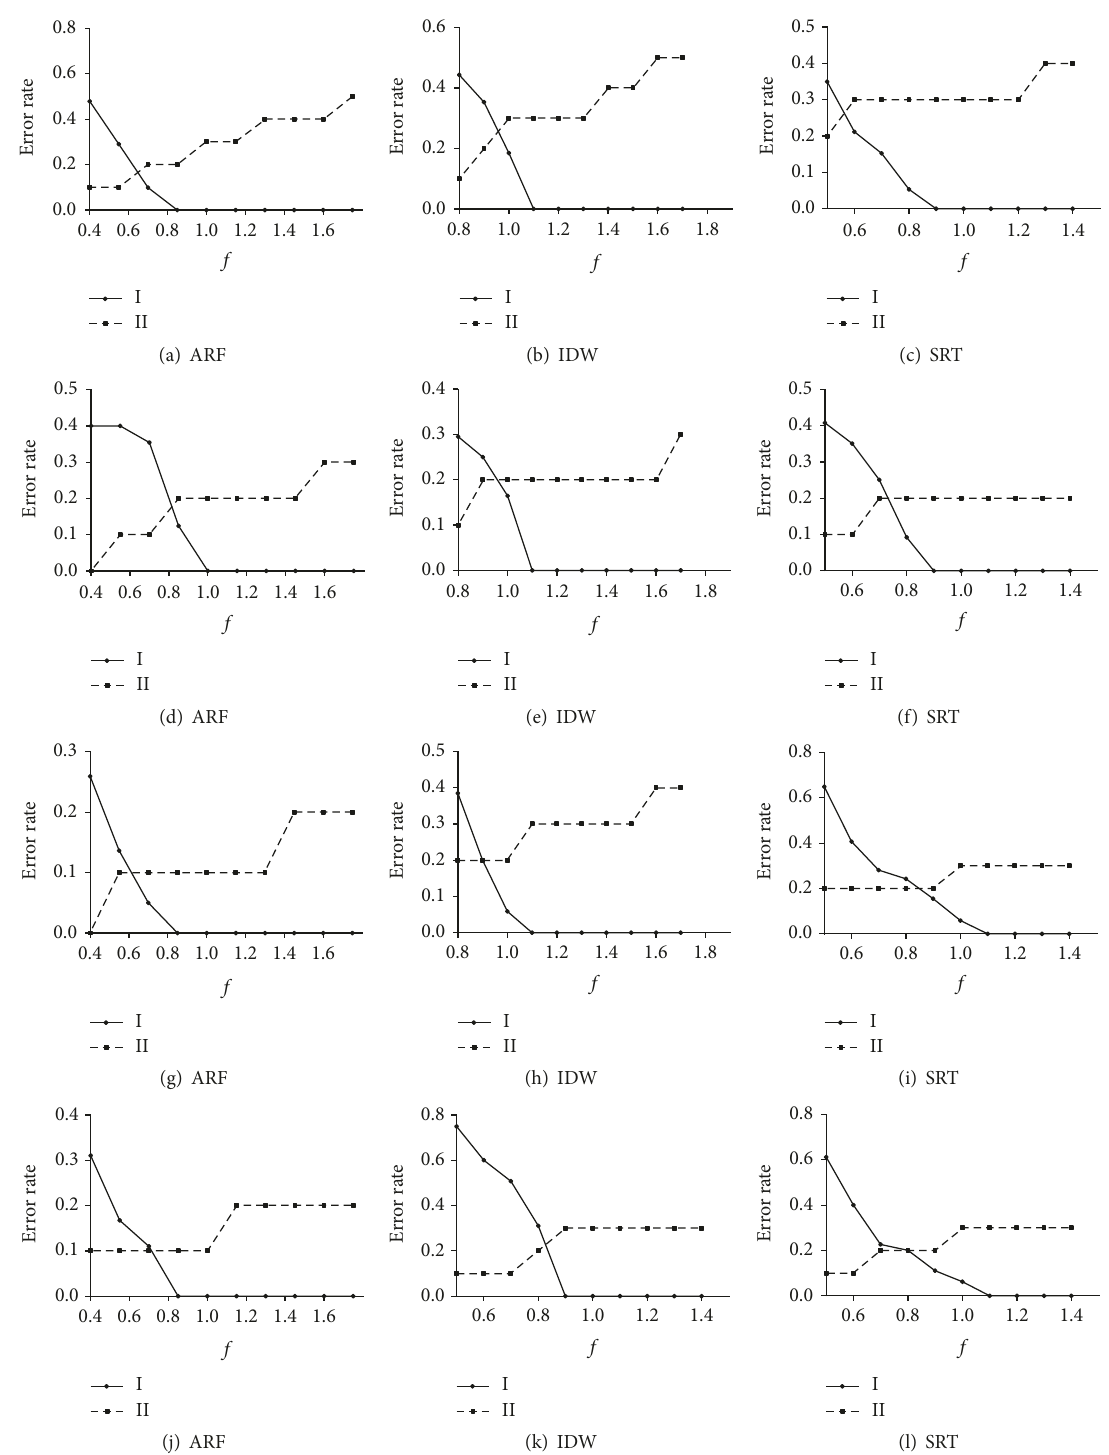
Figure 9: Comparisons of two types of errors for CD at 02:00 (a)–(c), 08:00 (d)–(f), 14:00 (g)–(i), and 20:00 (j)–(l).